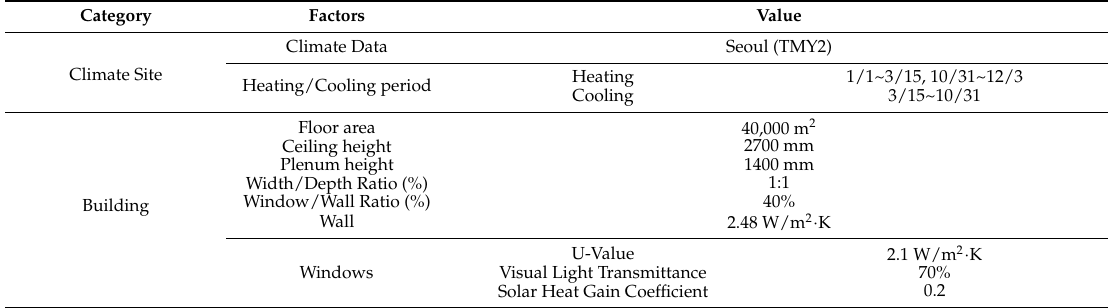
Table 2. Brief Description of the Baseline